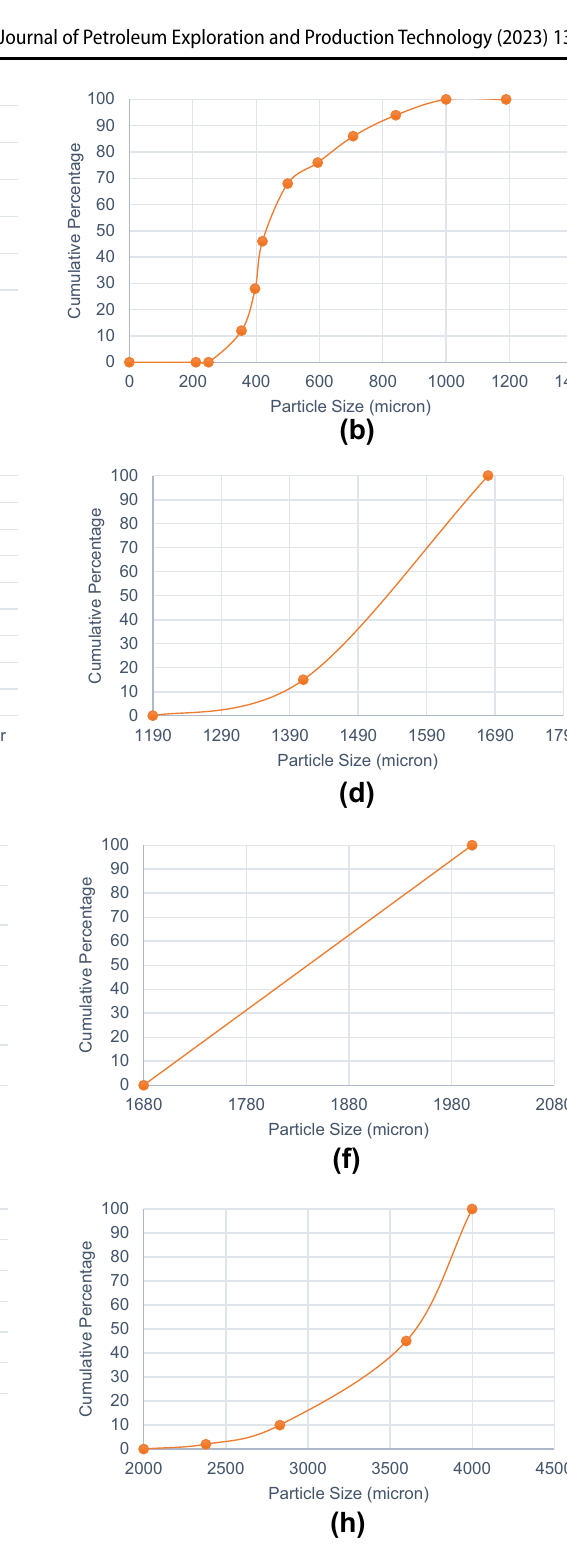
Fig. 6 a Mica particle size distribution (0–1190 micron), b Mica cumulative particle size distribution (0–1190 micron). c Mica parti- cle size distribution (1190–1680 micron). d Mica cumulative particle size distribution (1190–1680 micron). e Mica particle size